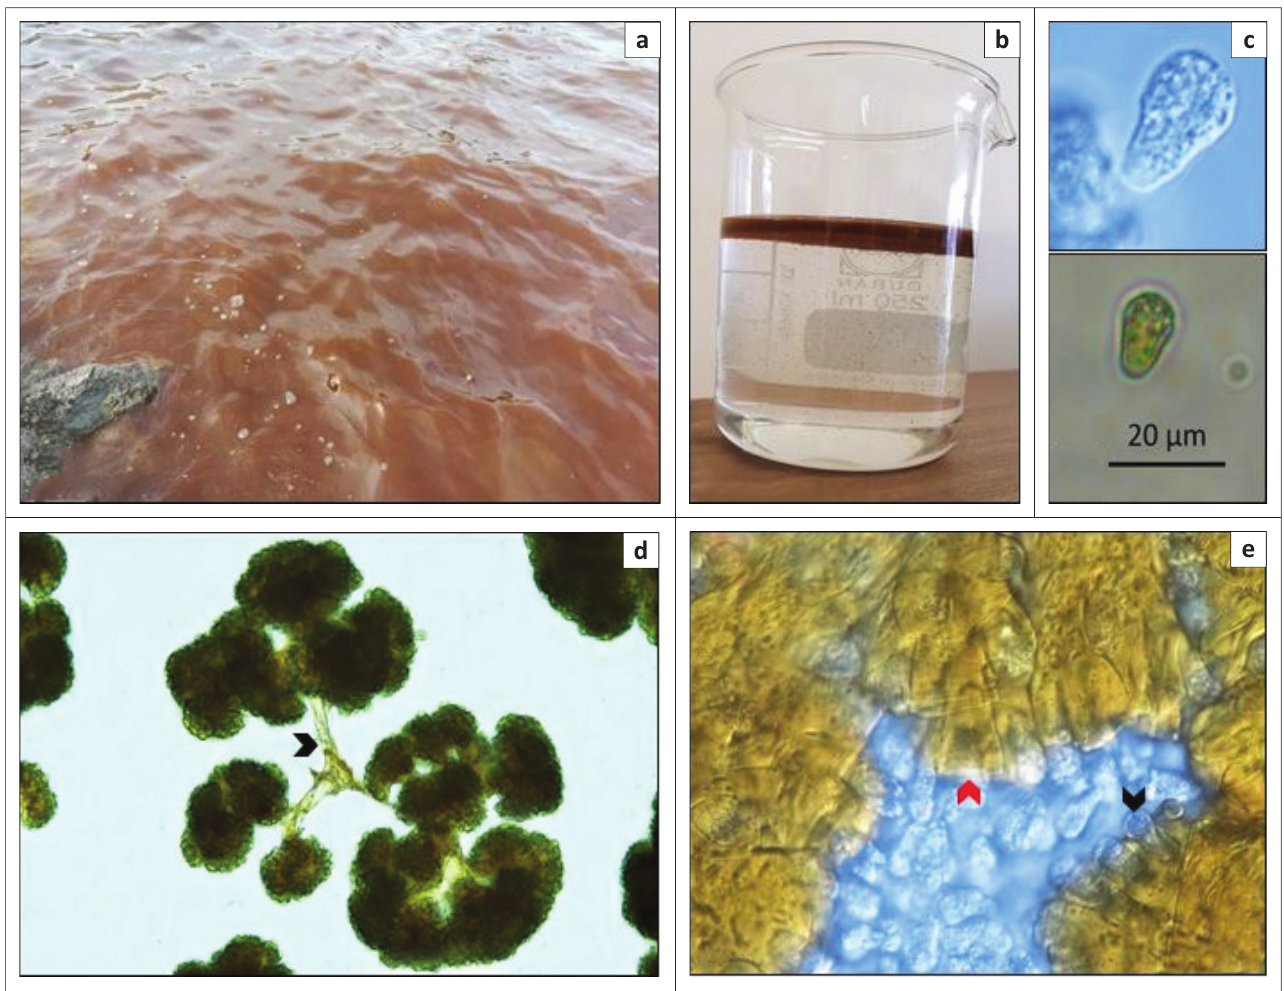
FIGURE 2: Field-, laboratory- and light microscope images of Botryococcus braunii . Diagnostic features are indicated with arrows. (a) Surface water of Tilda Viljoen Dam at the peak of the B. braunii bloom; (b) macroscopic B. braunii colonies floating in a layer on the surface; (c) structure of individual cells; (d) light microscope image of B. braunii colonies with subcolonies and linking threads (black arrow); and (e) cells embedded in cup-shaped structures (black arrow) and empty cups after cells have been released (red